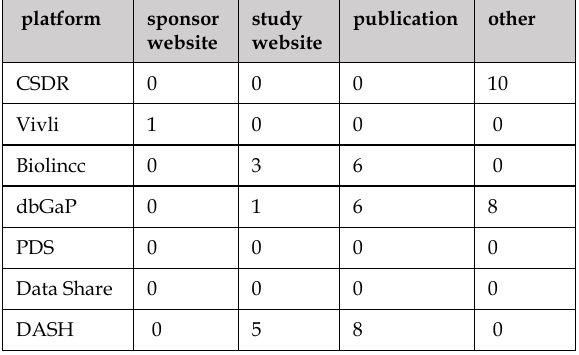
Table 4 Platforms’ Links to Other Resources